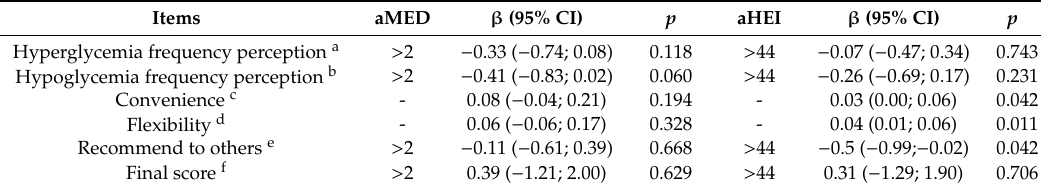
Table 4. Multivariable analysis of the Diabetes Treatment Satisfaction Questionnaire-status (DTSQ-s) with the alternate Mediterranean Diet Score and alternate Healthy Eating